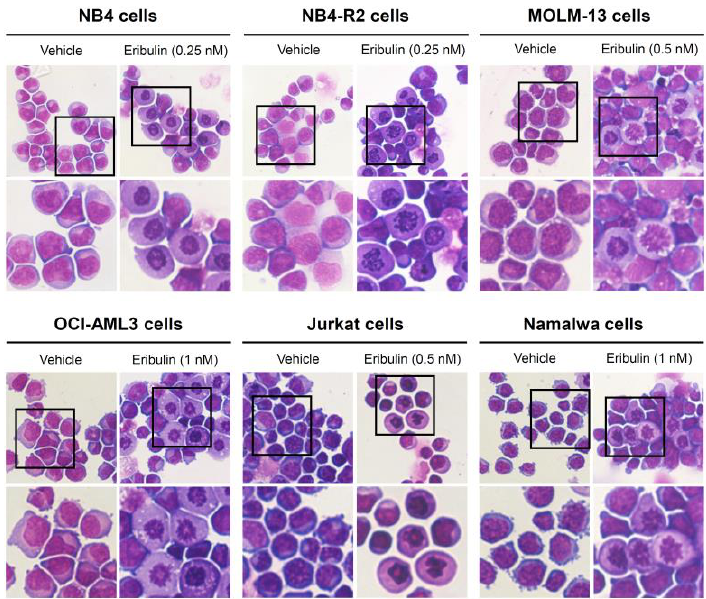
Figure 4. Aberrant mitoses are observed upon eribulin exposure in acute leukemia cells. NB4, NB4-R2, MOLM-13, OCI-AML3, Jurkat, and Namalwa cells were treated with vehicle or eribulin for 72 h, fixed, and stained with hematoxylin and eosin (H&E). The 400 × and 1000 × magnification images are displayed.